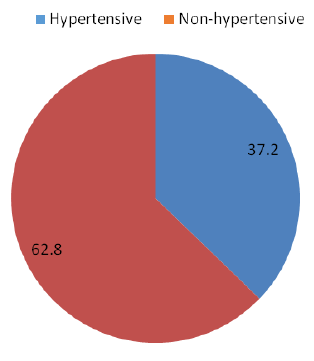
FIG:2:Chart displaying the prevalence of Figure 2. The prevalence of hypertension.